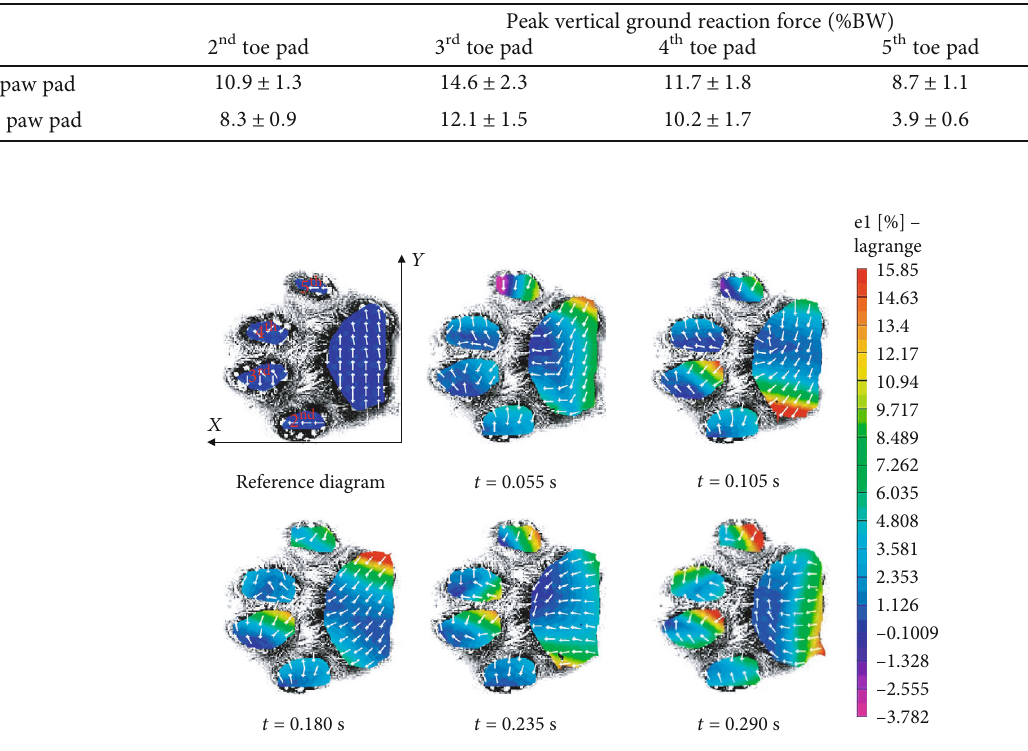
Figure 3: The contact strain results of fore paw pad ( t